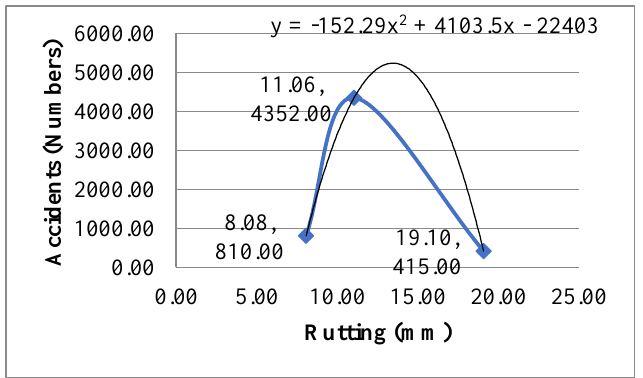
Fig. 12. Rutting vs. accident data